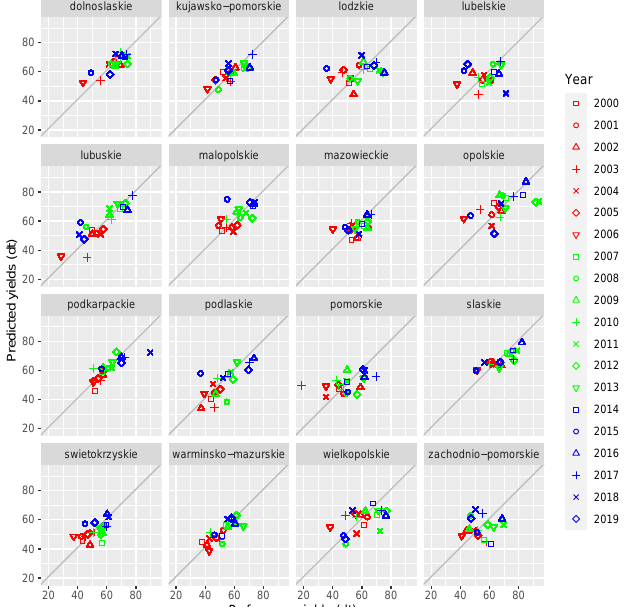
Figure 11. Comparison of crop yield predictions with the reference statistics for maize at NUTS-2 level. The RMSE and bias of this relationship is given in Figure 7.